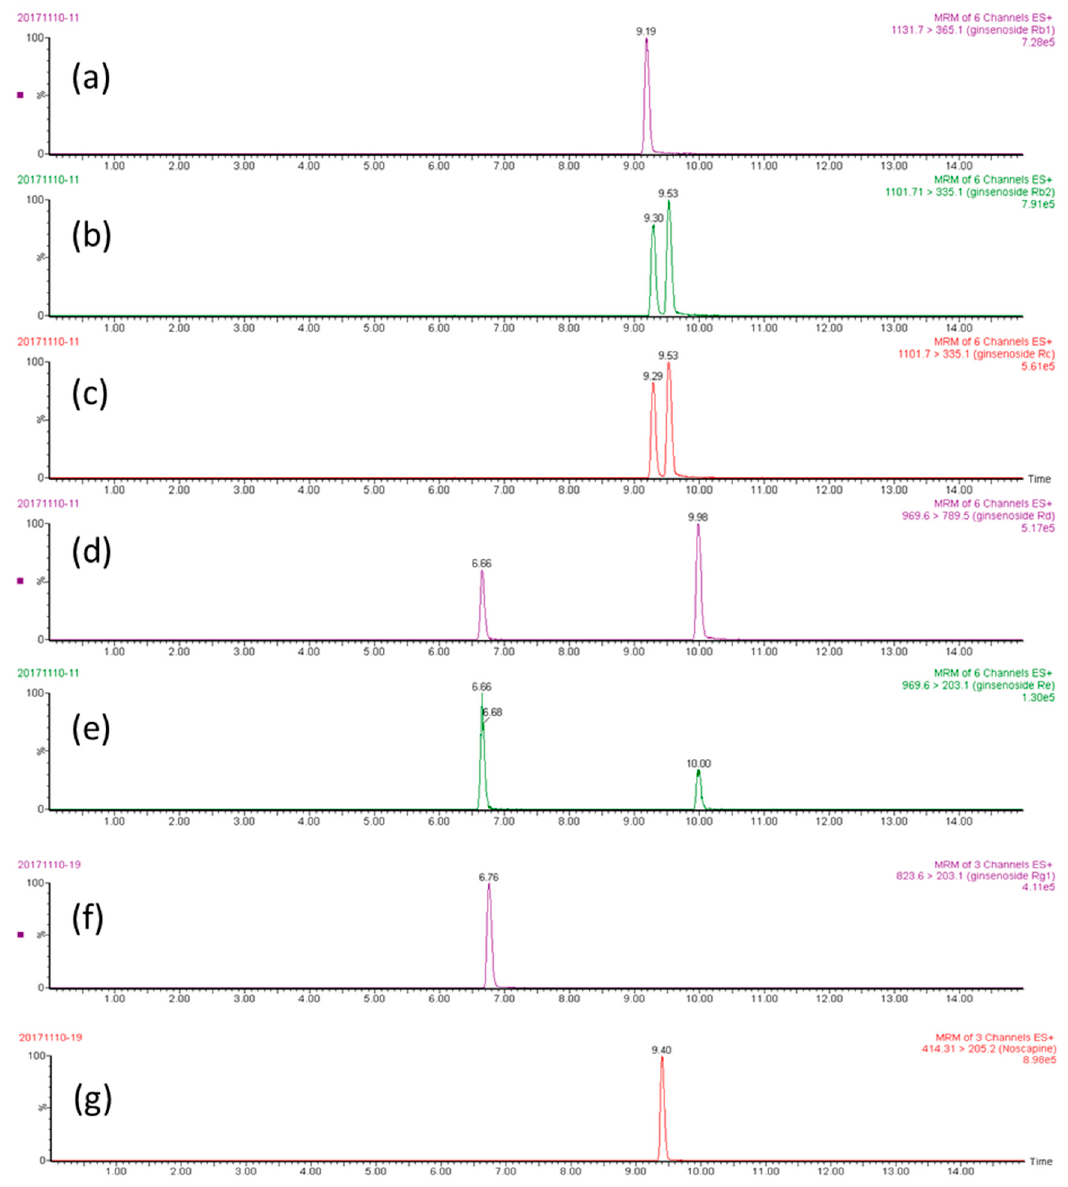
Figure 3. The multiple-reaction monitoring (MRM) chromatographs of analytes (500 ng/mL): ( a ) ginsenoside Rb 1 , ( b ) ginsenoside Rb 2 , ( c ) ginsenoside Rc, ( d ) ginsenoside Rd, ( e ) ginsenoside Re, ( f ) ginsenoside Rg 1 , and ( g ) noscapine (internal standard).